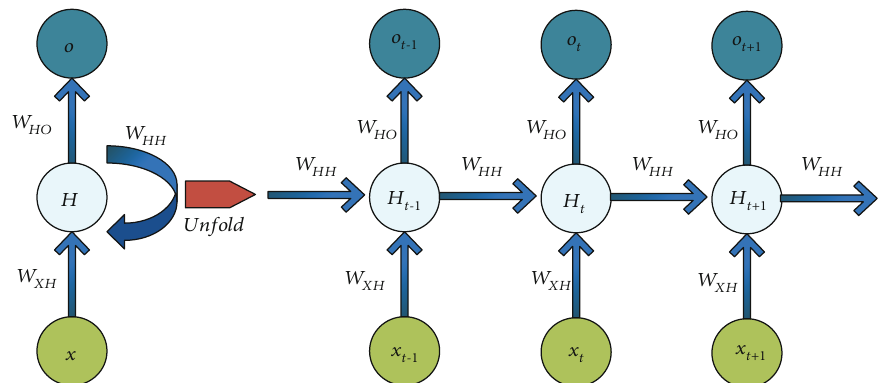
Figure 1: A RNN with its unfolded architecture.